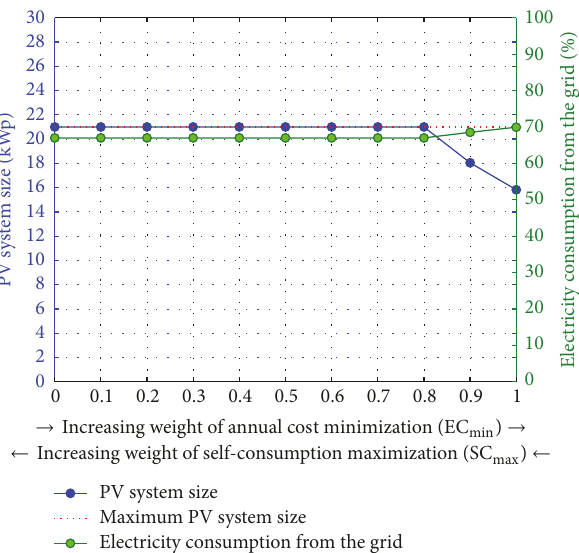
Figure 9: German retail electricity prices: comparison of annual electricity costs with and without a PV system installed.